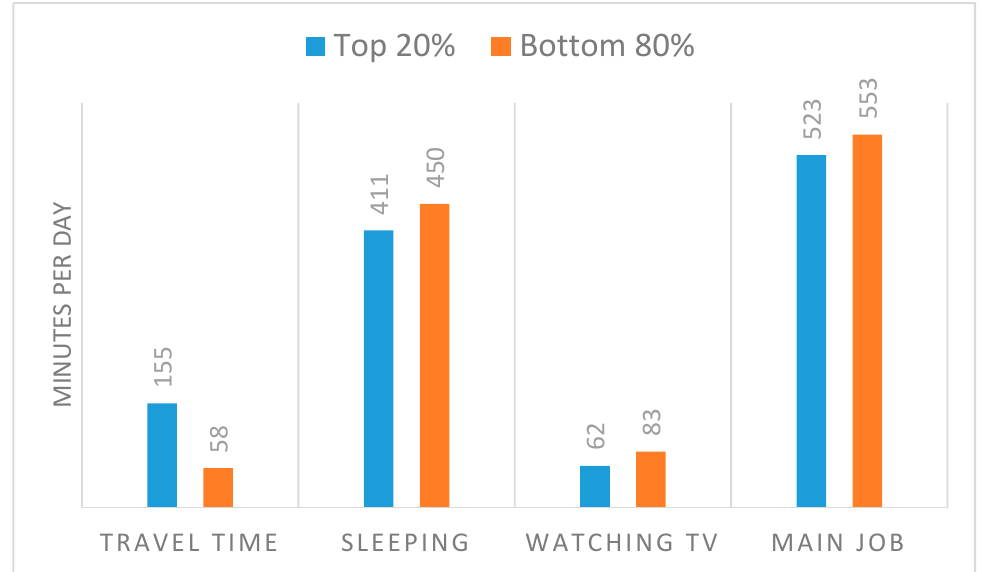
Figure 1. Professional workers: Average total time in a workday spent on select activities—top 20% travel time (Long commute drivers) versus bottom 80% travel time segments.